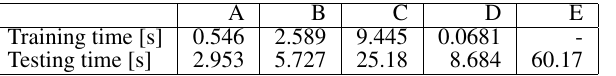
Table 2. Comparison of the computation times for the forest dataset. A: MLM (cosine, variance, training set size 2500, R size 250), B: One-Class-SVM, C: Isolation forest, D: Global RX, E: Local